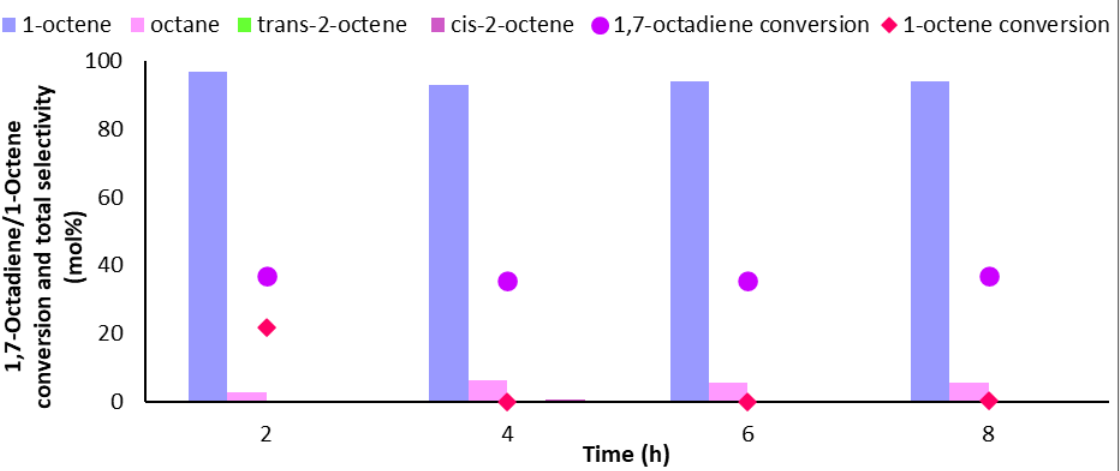
Figure 5. Conversion of 1,7-octadiene and 1-octene and selectivity to 1-octene, octane, and internal octenes over 1Pd9Ag-33%[N 4444 ][NO 3 ]. Reaction conditions: Temperature: 100 °C, Pressure: 30 bar, Diene:H 2 ratio: 1:3.5, LHSV: 9 h −1 , Feed: 2 wt% 1,7 octadiene, 10 wt% octene in hexane.